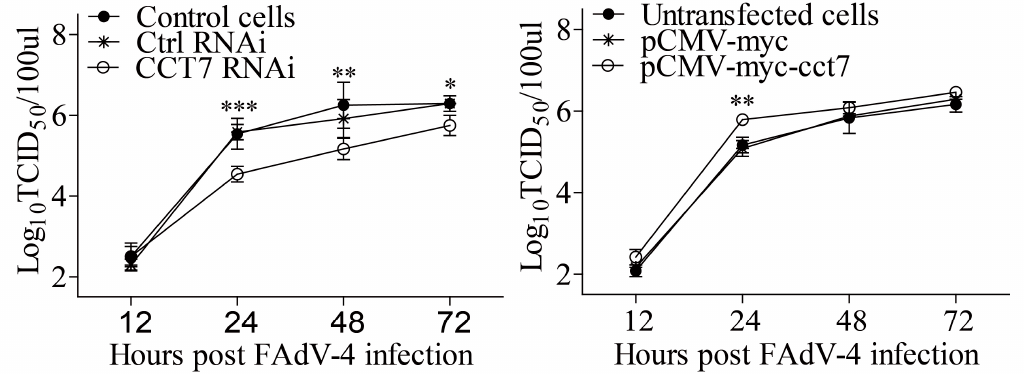
Figure 8. Effects of CCT7 on FAdV-4 growth in LMH cells. ( A ) Knockdown of CCT7 suppresses FAdV-4 growth. LMH cells were treated with RNAi to knockdown endogenous CCT7 expression as described above, followed by infection with FAdV-4 at an MOI of 1. At different time points (12, 24, 48, and 72 h) post FAdV-4 infection, the viral titers in the cell cultures were determined by TCID50 using 96-well plates. The significance of the difference between CCT7 RNAi treatment and RNAi controls was performed by ANOVA. ( B ) LMH cells were transfected with pCMV-myc-cct7 or empty vectors, followed by infection with FAdV-4 at an MOI of 1. At different time points (12, 24, 48, and 72 h) post FAdV-4 infection, the viral loads in the cell cultures were determined by TCID 50 using 96-well plates. The significance of the difference between pCMV-myc-cct7 transfected cells and controls in viral growth was determined by ANOVA. * stands for p <0.05, ** stands for p <0.01 and *** stands for p <0.001.